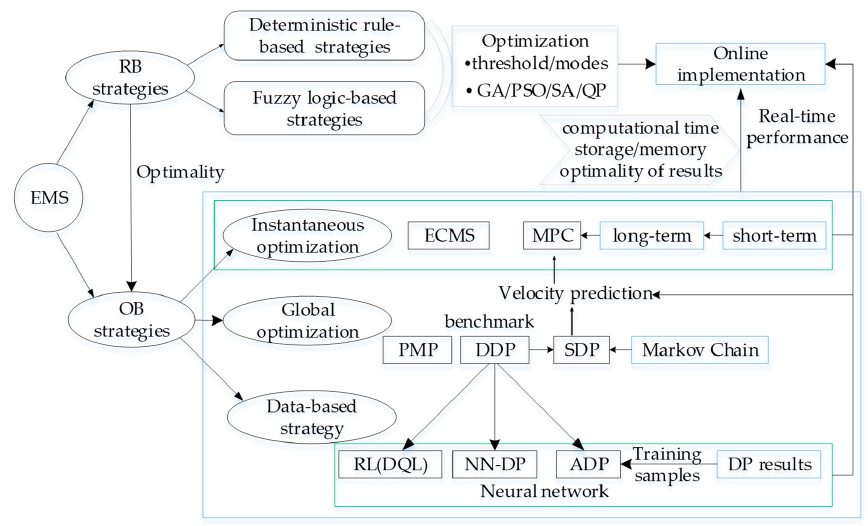
Figure 1. Depiction of the schematic diagram of this paper.